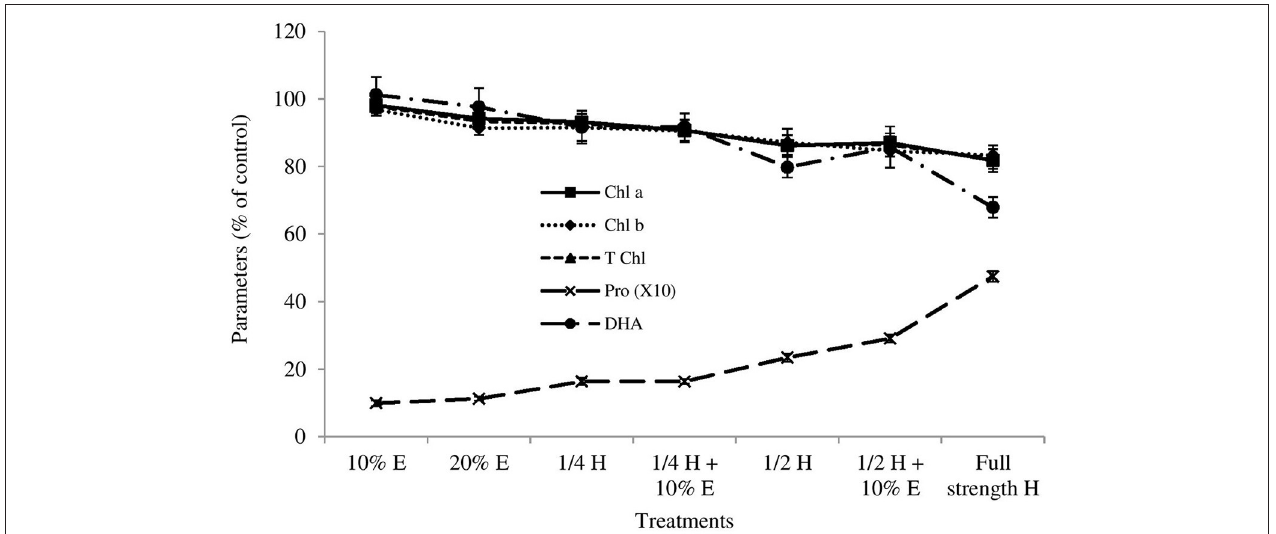
FIGURE 3 | Effects of boneseed extracts, herbicide and mixture on post-emergent ryegrass (3 days after spray). The x-axis denotes the treatment types (10% aqueous extract of boneseed leaf, 20% extract, ¼ strength herbicide, mixture of ¼ strength herbicide with 10% extract, ½ strength herbicide, mixture of ½ strength herbicide with 10% extract and full-strength herbicide). Values on y-axis denote the impact (% of control) on chlorophyll a (chl a) (solid line with square marker), chlorophyll b (chl b) (round dot line with diamond marker), total chlorophyll (T chl) (square dot line with triangular marker) and proline (pro) (long dash line with circle marker) content of ryegrass, and soil dehydrogenase activities (DHA) (long dash dot dot line with cross marker). The error bar indicates the standard error.